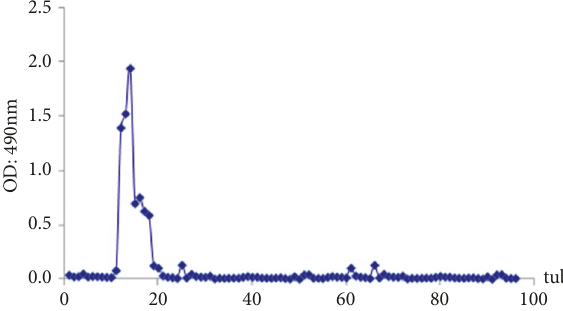
Figure 1: The elution curve of AMP